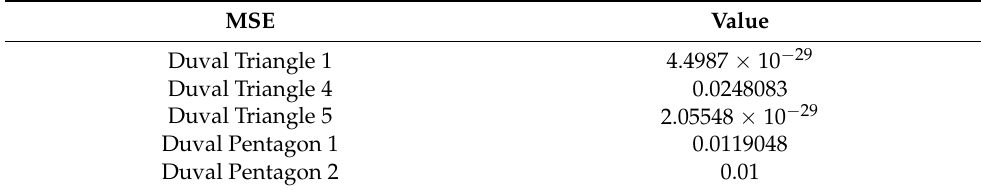
Table 11. Performances of the implemented neural networks.